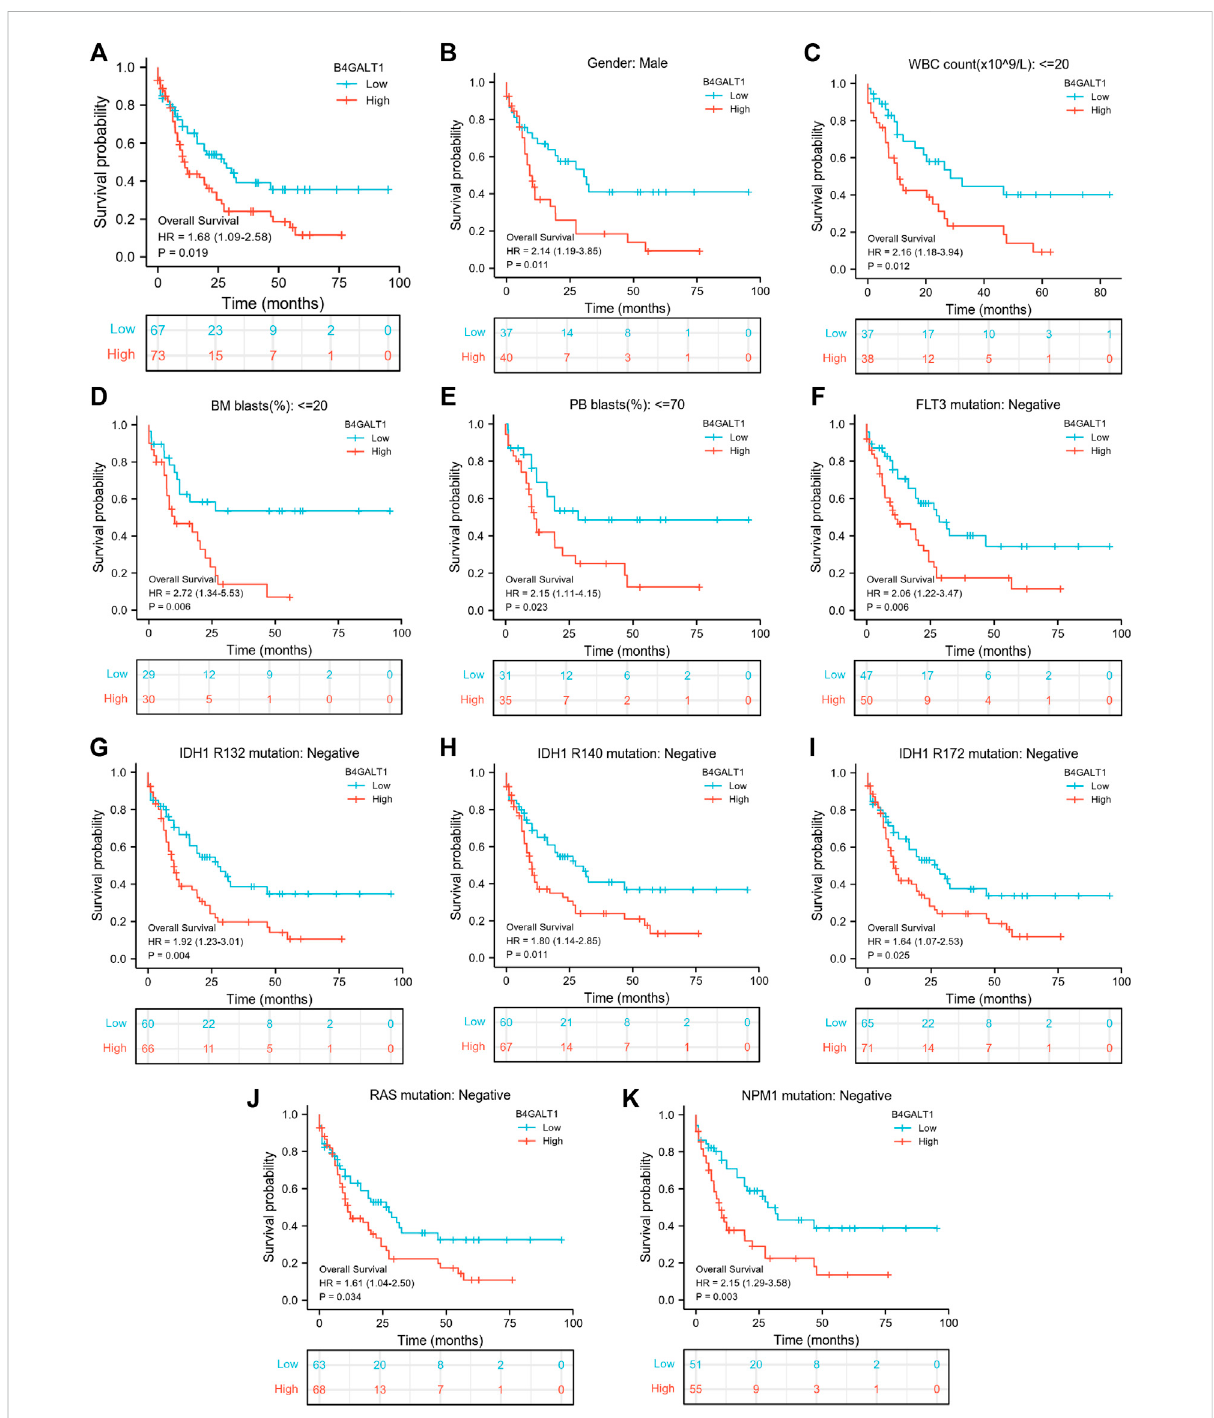
FIGURE 3 Kaplan-Meier survival curves compare B4GALT1 ’ s high and low expression in LAML patients. (A) Overall survival. (B) Kaplan-Meier curves in LAMLpatientswithMale. (C) Kaplan-MeiercurvesinLAMLpatientswithWBCcounts < =20×10 9 /L. (D) Kaplan-MeiercurvesinLAMLpatientswithBM blasts < 20%. (E) Kaplan-Meier curves in LAML patients with PB blasts ≤ 70%. (F – K) Kaplan-Meier curves in subgroups with FLT3 mutation-negative, IDH1 R132 mutation-negative, IDH1 R140 mutation-negative, R172 mutation-negative, RAS mutation-negative, and NPM1 mutation-negative in LAML